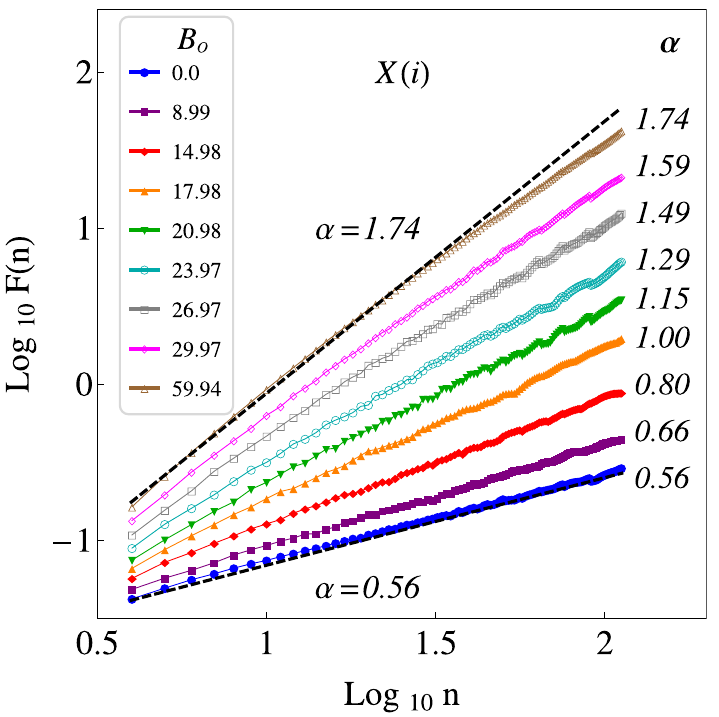
Figure 3. Results of applying DFA to the time series of the particle positions, X ( i ), for the same values of B o and φ s in Fig. 2. The exponent α is calculated from the slope of a straight line adjusted to each set of data. In both cases we can observe that the values of α increase, from α ≈ 0.5 to α ≈ 1.75 , as B o assumes higher values. The results correspond to an average over all the particles.